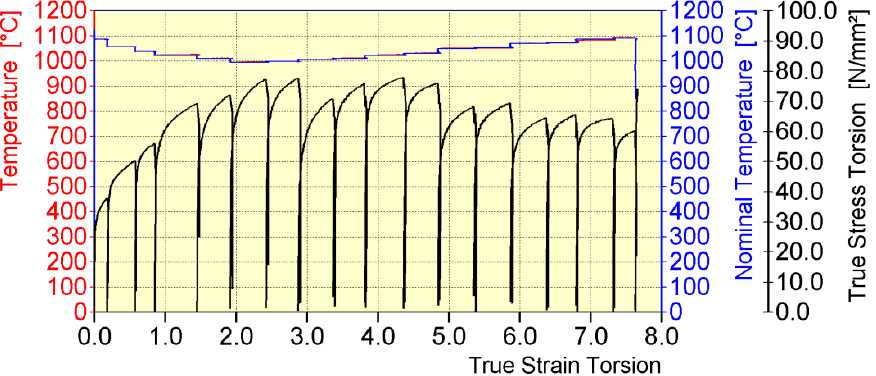
Figure 7. General course of temperature (nominal and obtained) and yield stress during physical modelling of rolling round 20MnB4 steel bars in a medium continuous rolling mill, for rolling a 5.5 mm diameter wire rod (test variants: V1, V2, and